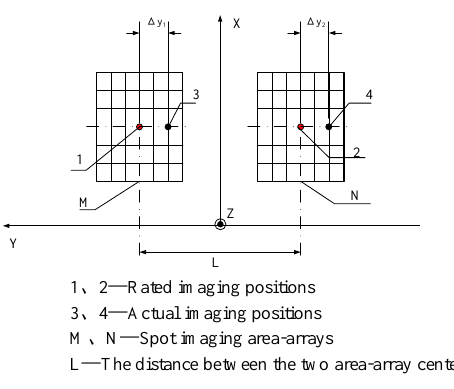
Figure 7. Changes in spot positions when the optical axis rotates around the X-axis